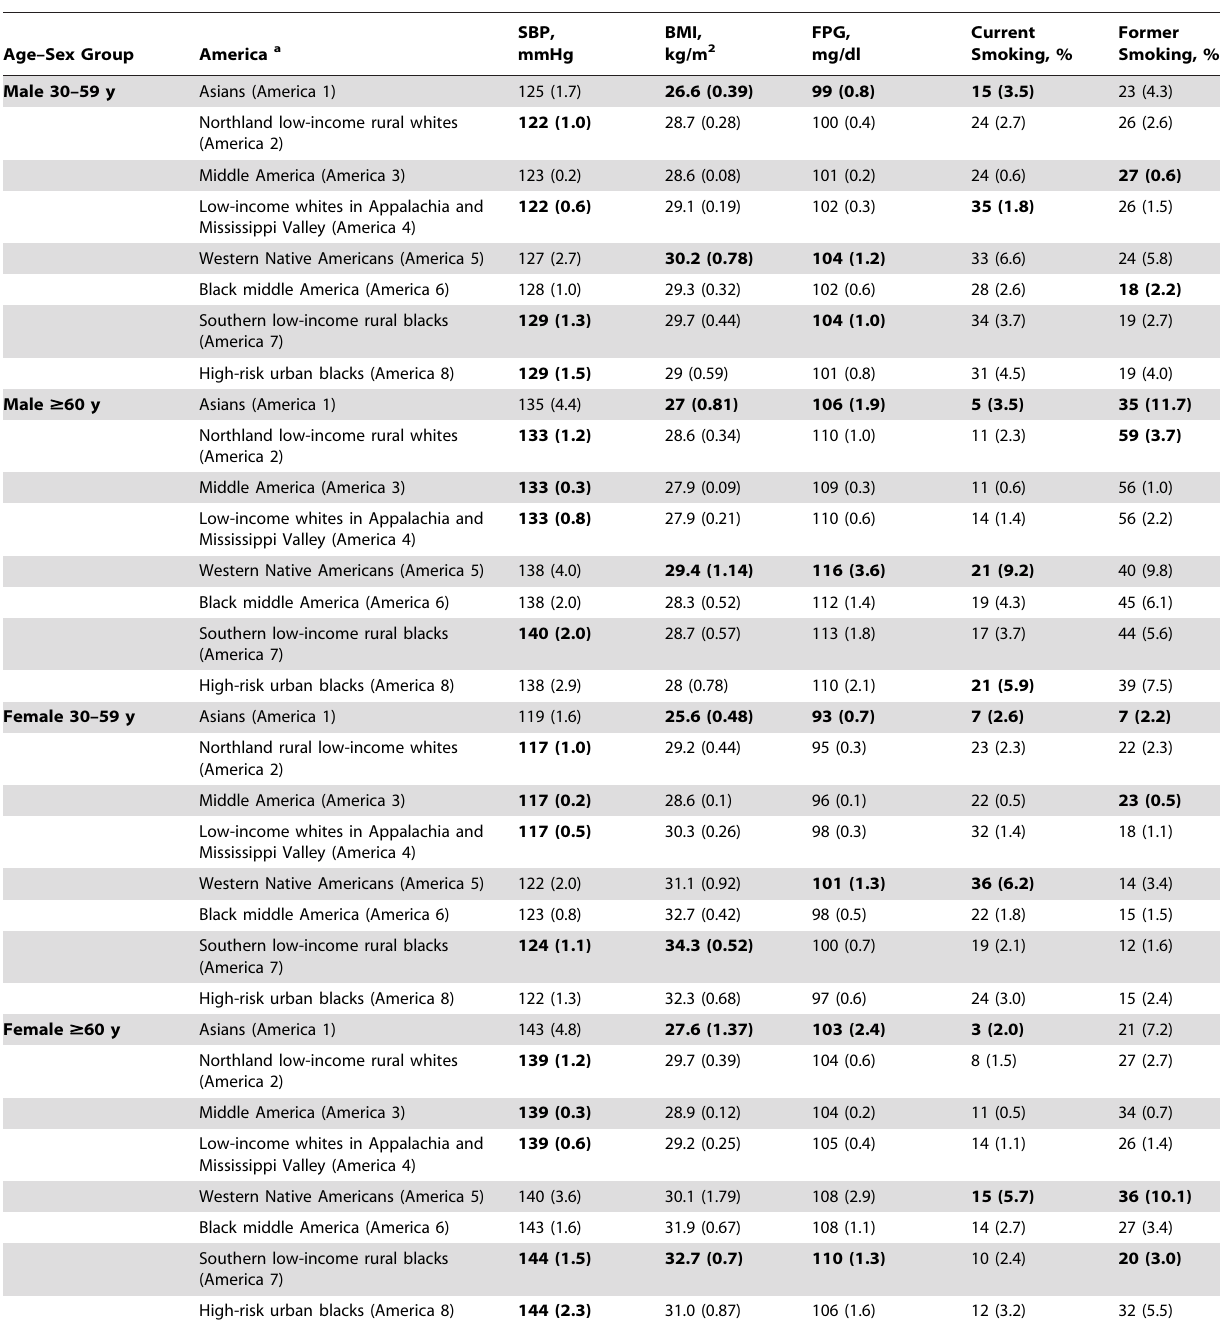
Table 3. Exposure to risk factors by sex and age group in the Eight